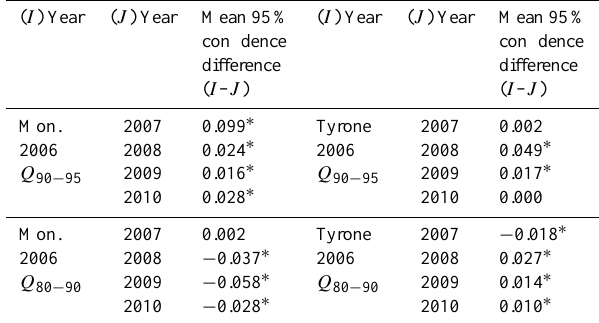
Table 6. Pairwise comparisons between years for TP concentra- tions. The mean difference is significant at the 0.05 level ( ∗ ), with TP as the dependent